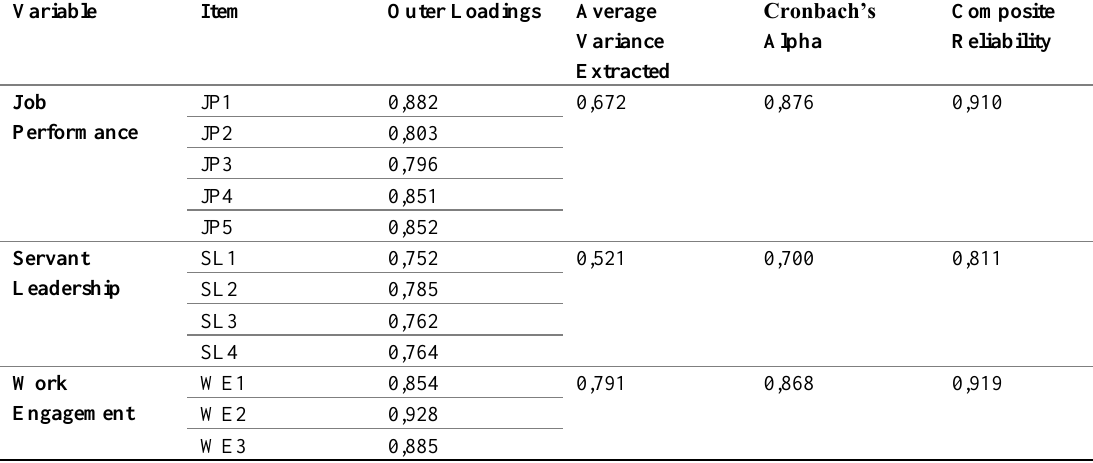
Table 1: Validity and Reliability of Indicator Measurement